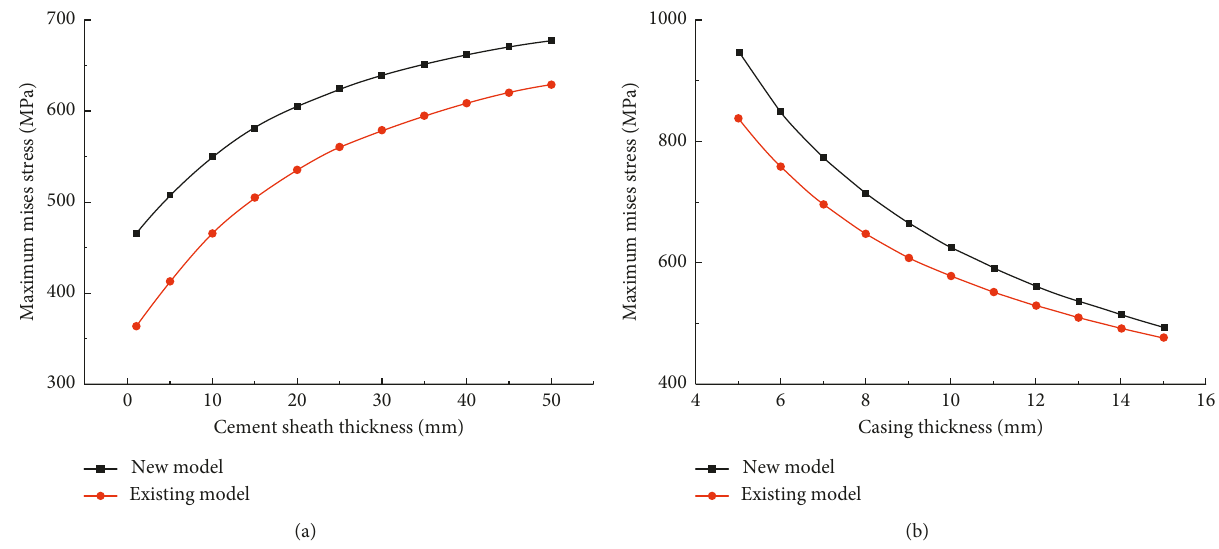
Figure 21: Casing Mises stress for different thicknesses of casing and cement sheath. (a) Different cement thickness. (b) Different casing